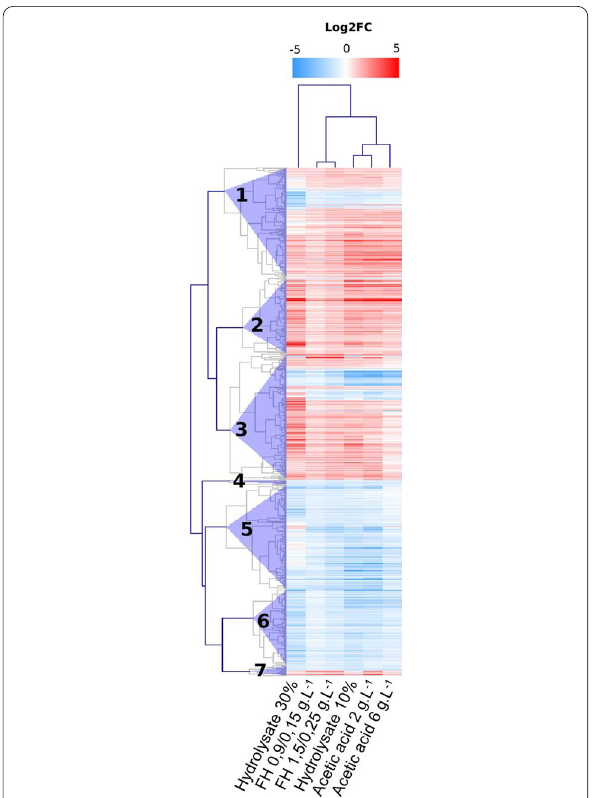
Fig. 6 Hierarchical clustering heat map of the 630 DEGs common in all categories. Changes in the expression are shown on a color scale, where red represents up-regulation and blue represents down-regulation. Each column relates to one inhibitory condition and each row represents one